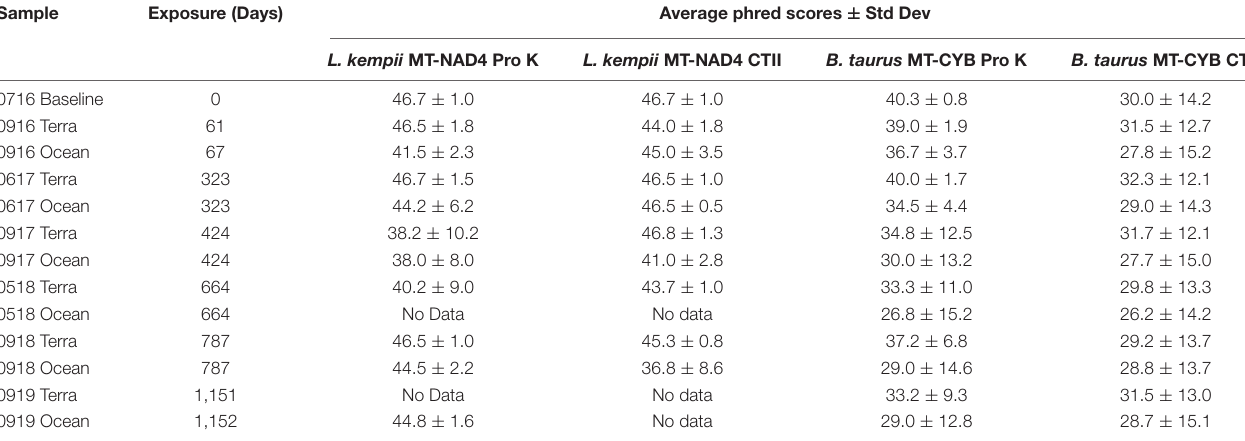
TABLE 2 | Average and standard deviation values for phred scores following DNA sequencing for Pro K and CTII treatment.